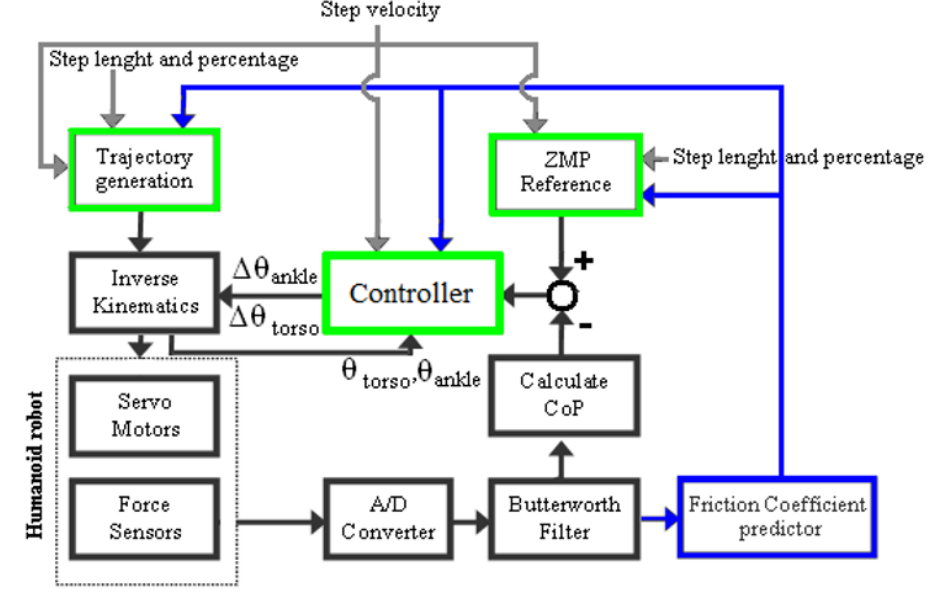
Figure 13. High level block scheme for the gait adaptation The final system for the balance controller is represented in Figure 13 . The green rectangles refer to the controller part, responsible for the adaptation of the gait parameters and ZMP correction. The blue rectangle is concerned with the measurement of the foot-floor friction coefficient. The black rectangles are responsible for low-level robot manipulation techniques.